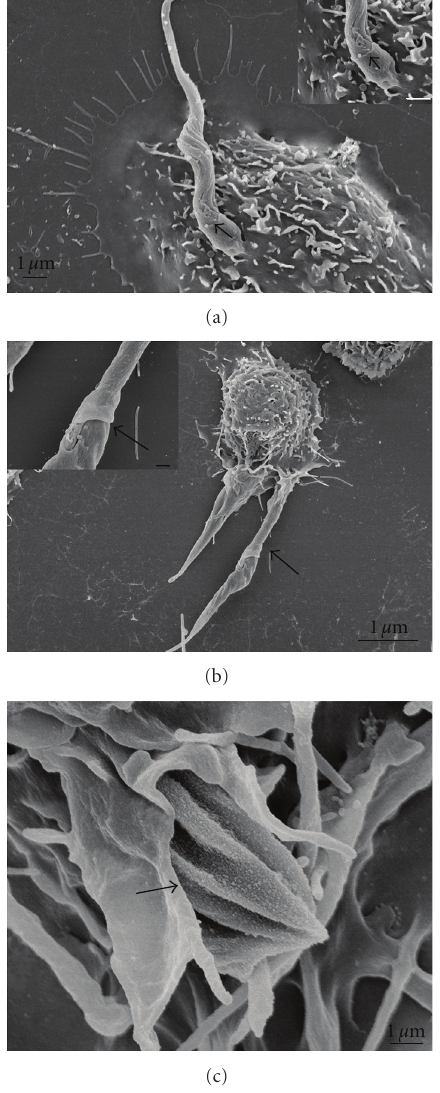
Figure 8: Field emission scanning electron microscopy of the interaction between peritoneal macrophages treated with dynasore 60 μ M (for 20 minutes) and allowed to interact with T. cruzi trypomastigotes (a), epimastigotes (b), and amastigotes (c). All parasite evolutive forms were partially recovered by the macrophage plasma membrane indicating that the blockage of GTPasic dynamin activity did not impair the pseudopod extension, impairing only the complete vacuole formation. The interaction time was enough to complete the parasite entry into control macrophages. Bars = 1 μ m (after